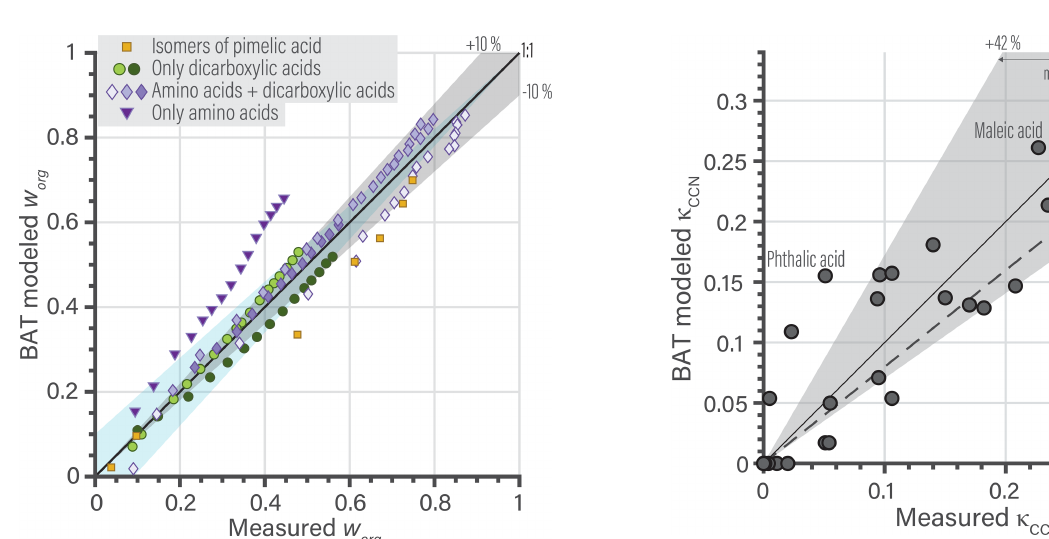
Figure 11. Comparison of BAT model predictions of w org with measurements from a comparative kinetic electrodynamic balance by Marsh et al. (2019). The amino acids are glycine, lysine, and arginine; the dicarboxylic acids are oxalic, malonic, glutaric, and methylsuccinic acid; the isomers are pimelic acid, 2,2-dimethyl glu- taric acid, and 3,3-dimethyl glutaric acid. Gray shading: ± 10% un- certainty in w org ; blue shading: ± 10% uncertainty in w water ( = 1 − w org ) . The compositions of each mixture are listed in the Sup- plement.